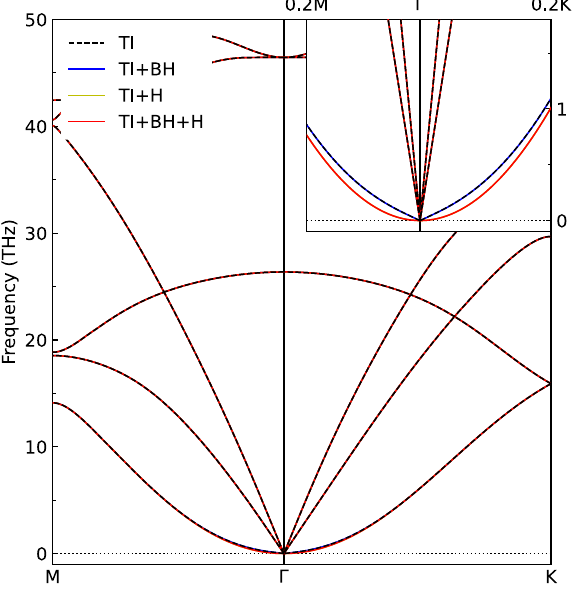
Fig. 3 Invariance conditions applied on the phonon dispersion of graphene. TI denotes the correction of translational invariance on the IFCs, while BH and H represent the corrections by Born-Huang rotational invariance and Huang conditions, respectively. The inset shows a zoom-in result around the Γ point. The yellow line coincides with the red one as the rotational invariance is automatically satis fi ed in graphene.